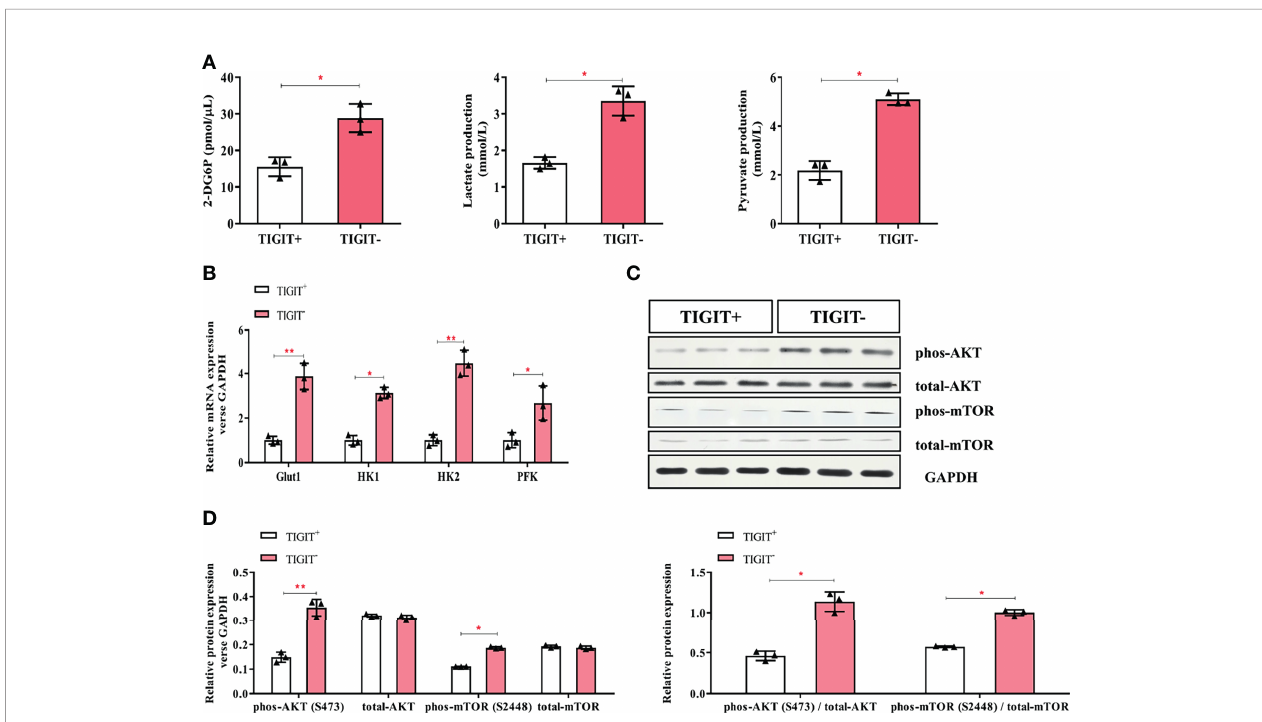
FIGURE 3 | Glycometabolism of TIGIT + CD3 + T cells is decreased in colorectal cancer patients. TIGIT + CD3 + T cells were sorted from PBMC of colorectal cancer patients. (A) The concentration of 2-DG6P, Lactate and Pyruvate was reduced in TIGIT + CD3 + T cells compared to TIGIT - CD3 + T cells. (B) Glut1, HK1, HK2, and PFK were measured by RT-PCR and mRNA expression was quanti fi ed. Glut1, HK1, HK2, and PFK elevated in TIGIT + CD3 + T cells. (C) Representative blots of western blotting were shown. (D) Western blotting analysis was performed to determine the phosphorylation levels of the AKT/mTOR pathway. The results were normalized to GAPDH expression and presented as relative protein expression. * P < 0.05; ** P <